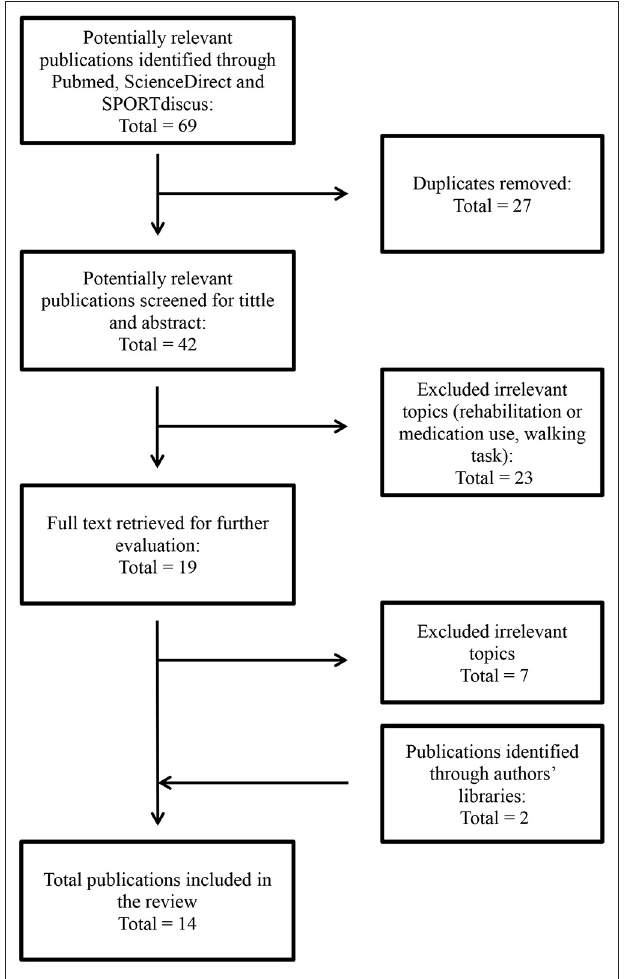
FIGURE 1 | Flowchart of the systematic literature search. The figure was inspired by Moher et al.